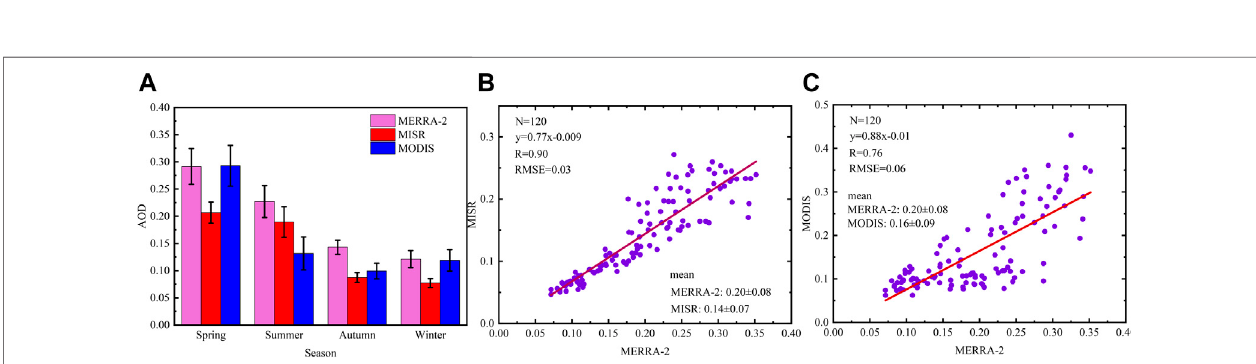
FIGURE2|(A) SeasonalvariationsintheTPAODfromtheMERRA-2.MODISandMISRretrievalsduring2009 – 2018andcomparisonofMERRA-2AOD, (B) MISR AOD, and (C) MODIS AOD over the TP (70 – 110 ° E, 25 – 45 ° N) for 2009 – 2018. The red line is the fi t